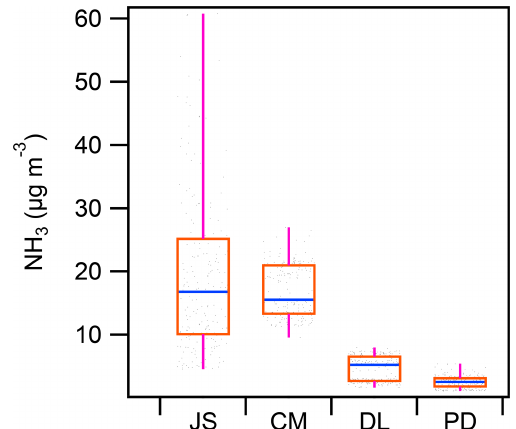
Figure 3. NH 3 at different sampling sites over the same period (From 18–27 January 2018). The locations of all sites are shown in Fig. 1. Scattered dots indicate raw data